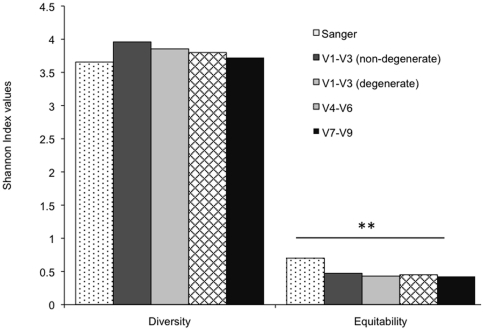
Shannon diversity and equitability indices of pyrotag and Sanger communities.No differences were detected between any of the pyrotag communities; however, the Sanger community demonstrated significantly greater equitable than all the pyrotag communities (** p<0.01, ANOVA).